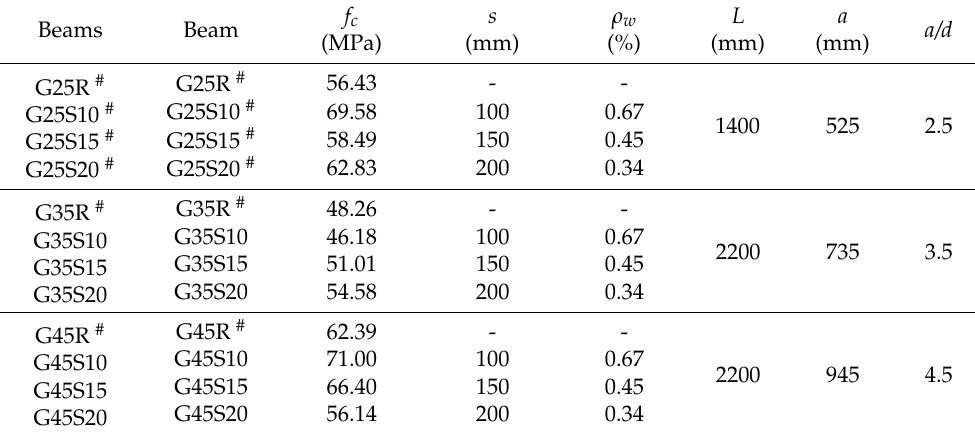
Table 2. Properties of